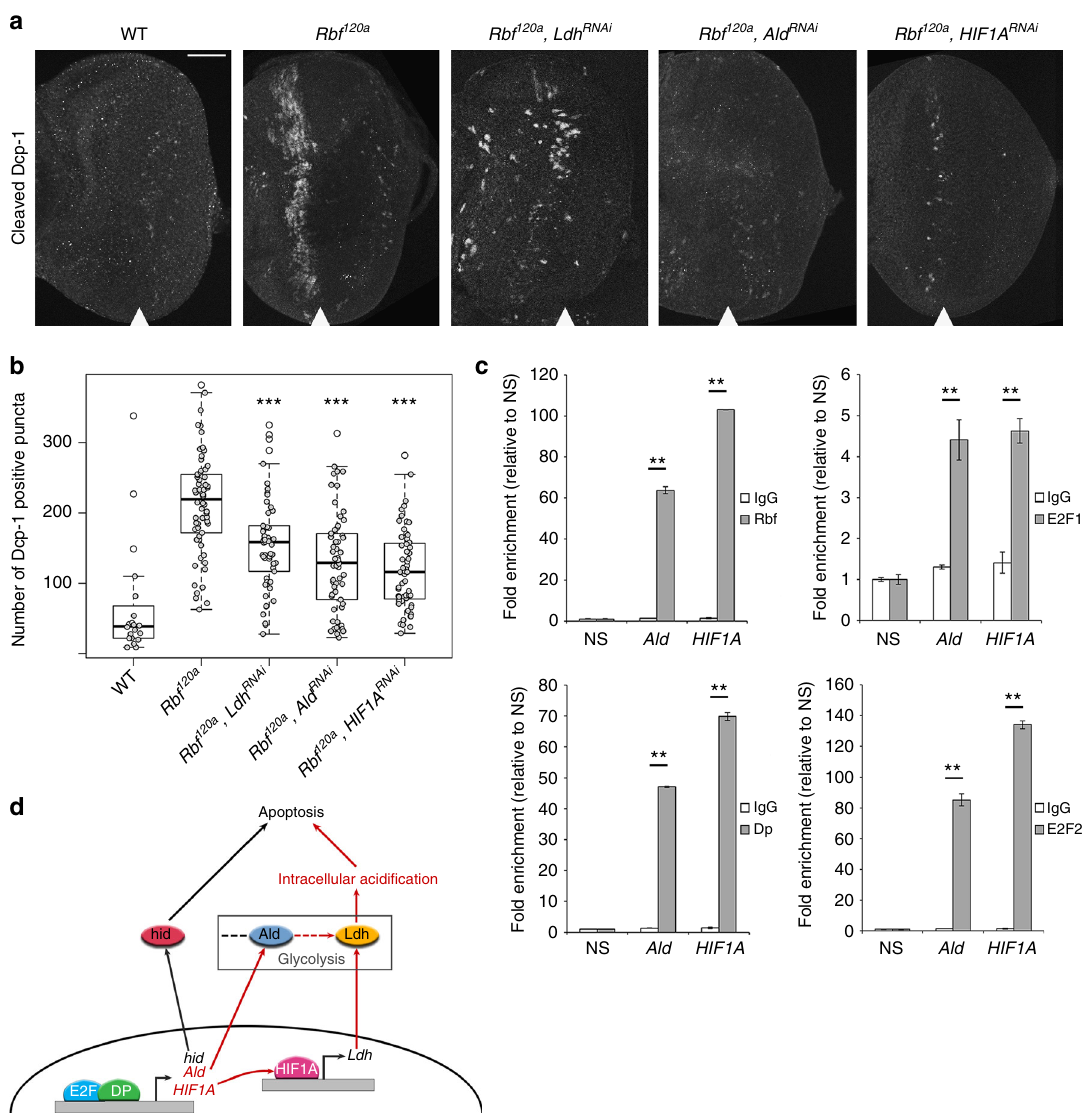
Fig. 6 Upregulation of Ldh , Ald and HIF1a make Rbf mutant prone to apoptosis. a Cleaved Dcp-1 immuno fl uorescence displays the distinct wave of apoptosis in Rbf 120a that is rescued by downregulation of each Ldh , Ald and HIF1a . The scale bar is 50 µ m. b Quanti fi cation of cleaved Dcp-1-positive puncta in N (WT) = 20 eyes, N ( Rbf 120a ) = 62 eyes, N ( Rbf 120a , Ldh RNAi ) = 54 eyes, N ( Rbf 120a , Ald RNAi ) = 58 eyes, and N ( Rbf 120a , HIF1A RNAi ) = 59 eyes. Center box line represents the median. The lower box limit is the fi rst quartile. The upper box limit is the third quartile. The whiskers point at the variabilities outside the fi rst and third quartiles. Values outside the whiskers are outliers. The hollow circles are outliers. One-way analysis of variance (ANOVA) test compares knockdowns versus Rbf 120a , ***adjusted p value < 5 × 10 -4 . c ChIP-qPCR performed on larval chromatin using Rbf, E2f1, E2f2 and Dp antibodies at the promoter regions of Ald and HIF1a relative to the negative site (NS). Data are representative of two experimental replicates and show the mean and error bars represent s.e.m., two-way ANOVA test was used, ** p value < 0.001. d Molecular mechanism of the metabolic aspect of apoptosis in Rbf mutant